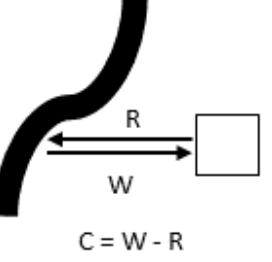
Figure 1. The trivial, but confounding, simple net consumptive use case. Water is withdrawn ( W ), rapidly used by a single user or group of users, and then a smaller amount is returned ( R ) immediately to the exact point of withdrawal at sufficiently similar water qual- ity. This is a convenient accounting for water resource management work, but it belies the significant complications involved in real- world water uses (see Fig.